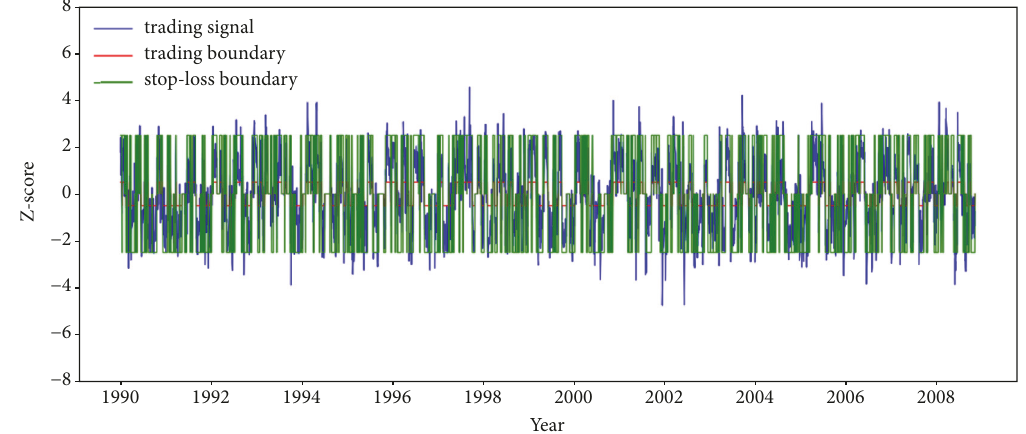
Figure 8: An example of PTA0 based on a training scheme using OLS.